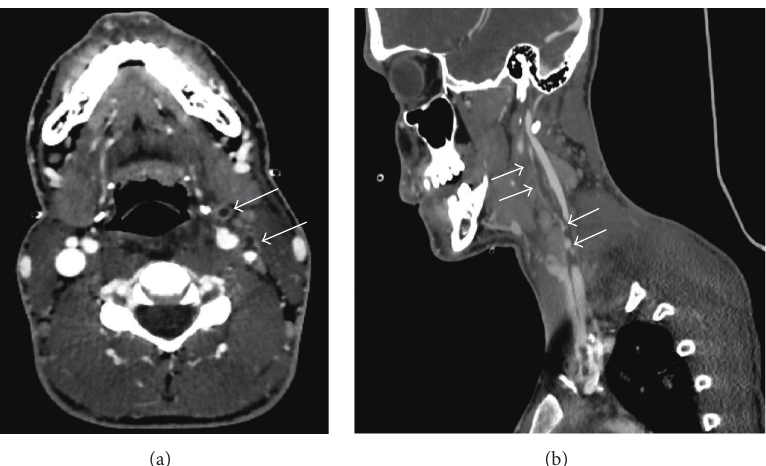
Figure 1: Left jugular vein thrombosis associated with thrombosis of collateral veins (white arrows in panels (a) and (b)) and cervicofacial cellulitis.